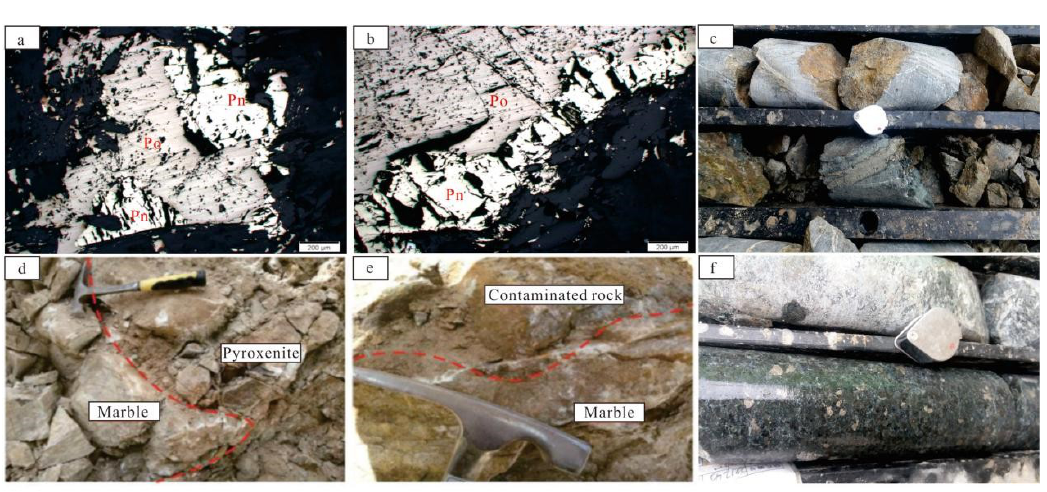
Figure 3. ( a , b ) Microphotographs of ore samples in Akechukesai IV mafic–ultramafic complex; ( c – f ) Field and core photos of Akechukesai IV mafic–ultramafic complex. Abbreviations: Pn = Pentlandite, Po = Pyrrhotite.